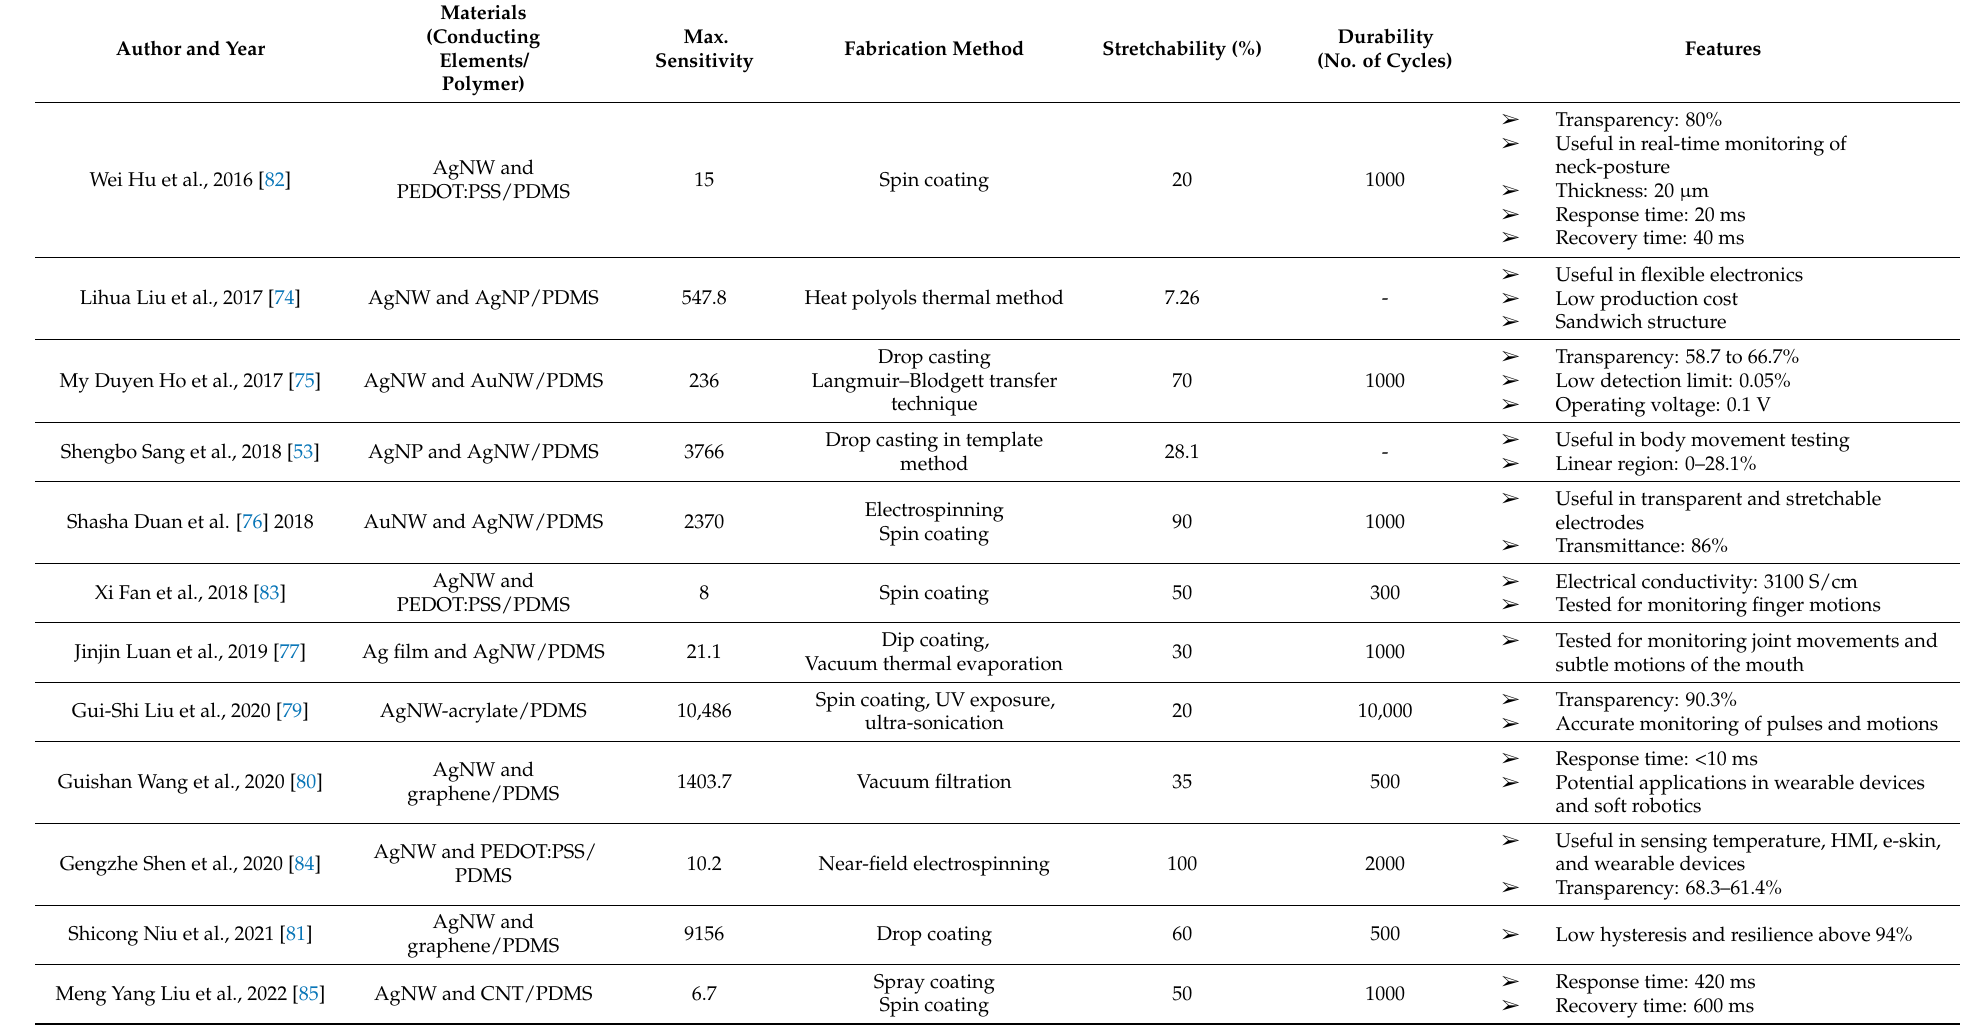
Table 2. An overview of recent research works relating to AgNWs as an additional filler in the strain-sensing PDMS